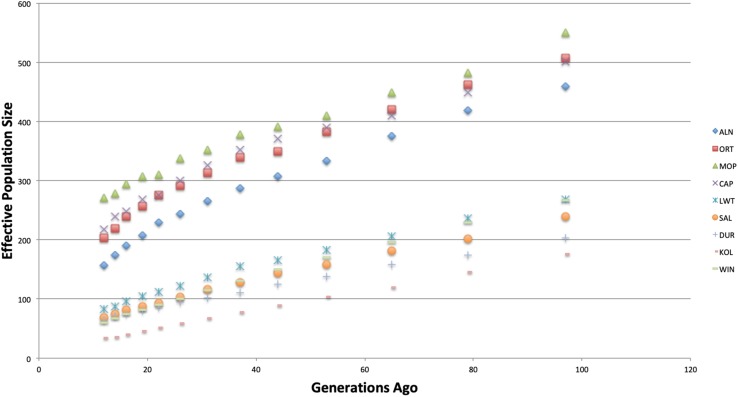
Average effective population size plotted against generation in the past.